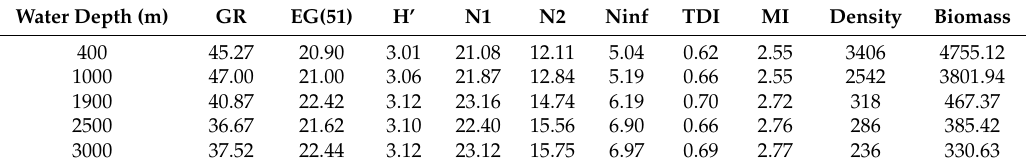
Table 2. Average structural and functional nematode community parameters. GR: genus